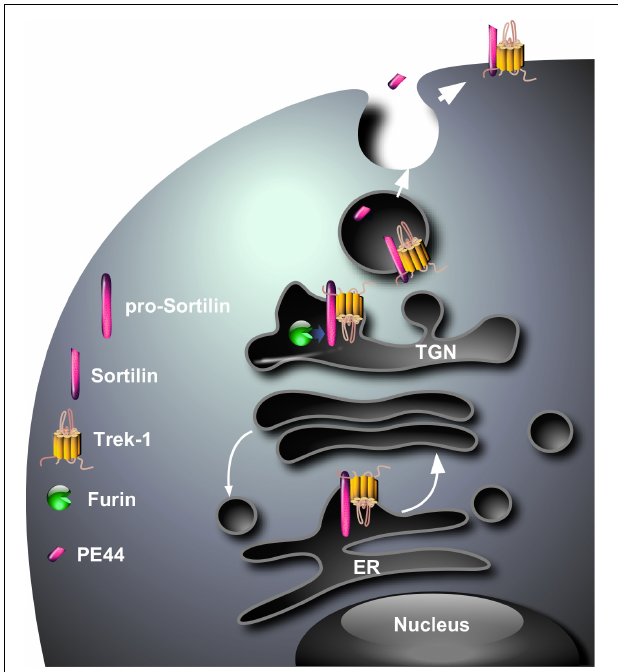
FIGURE 1 | Hypothetical model for the cellular sorting of the complex sortilin/TREK-1. The complex that is probably formed in endoplasmic reticulum (ER) translocates to the Trans -Golgi Network where the PE is cleaved by the protein convertase furin. The complex sortilin/TREK-1 can be addressed via constitutive secretory vesicles from the TGN to the plasma membrane where the PE (PE44) is released in the circulation.